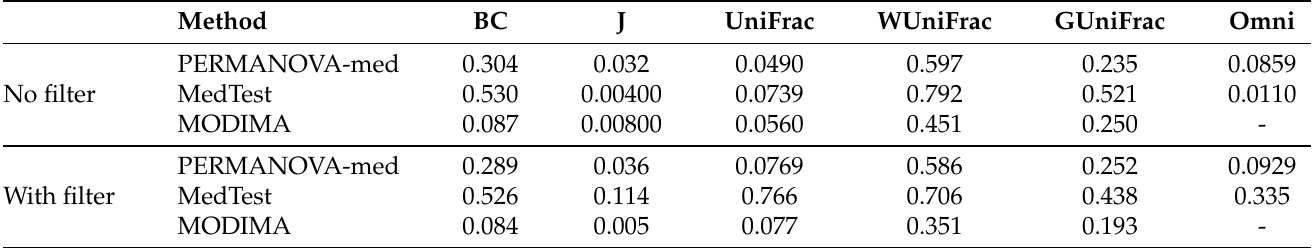
Table 4. p -values from testing the mediation effect by the gut microbiome in the effect of dietary fiber intake on